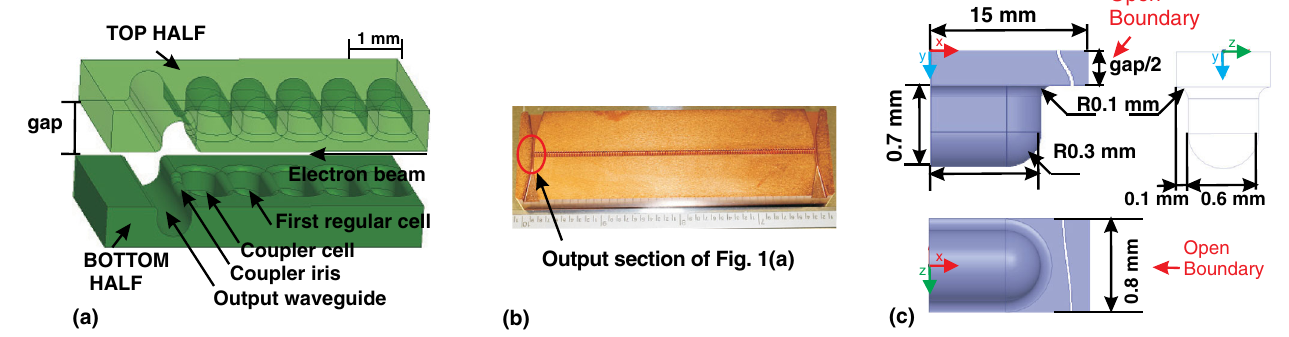
FIG. 1. Solid model of the output section of the mm-wave traveling wave accelerating structure, including output coupler and waveguides (a), photo of the copper half structure (b), geometry of one quarter of the vacuum part of the regular cell (c).